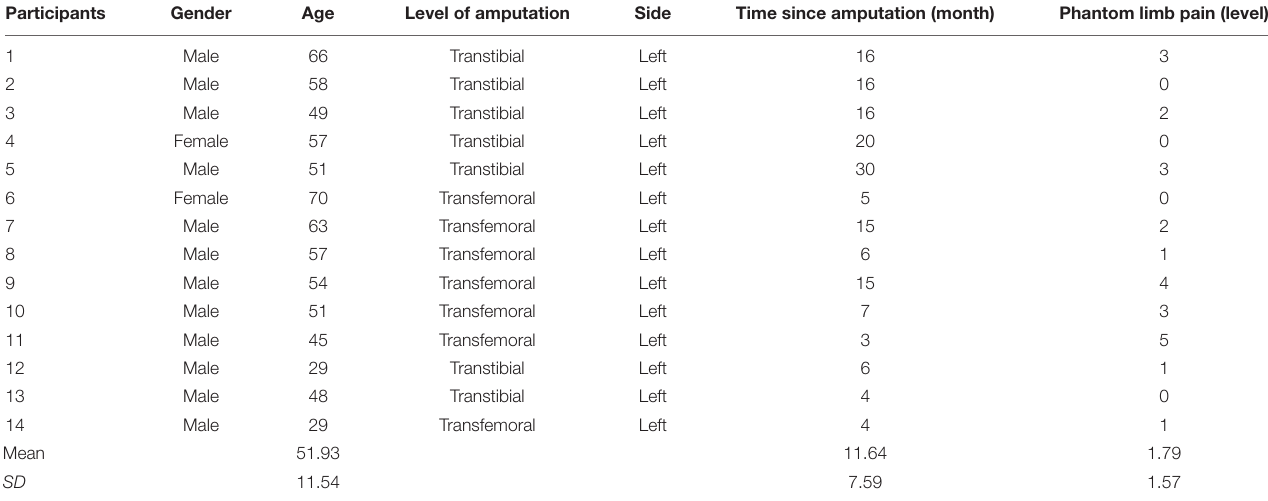
TABLE 1 | Detailed clinical characteristics of amputees.